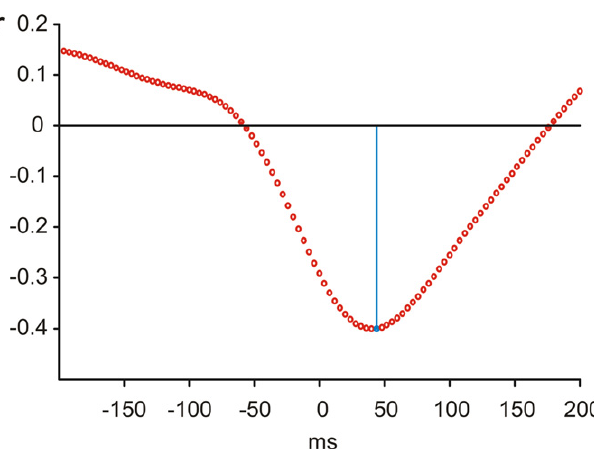
Figure 5. Cross-correlation of surface and Nacc single trial brain activity. Cross-correlation analysis indicates a delay of surface activity by about 40 ms.